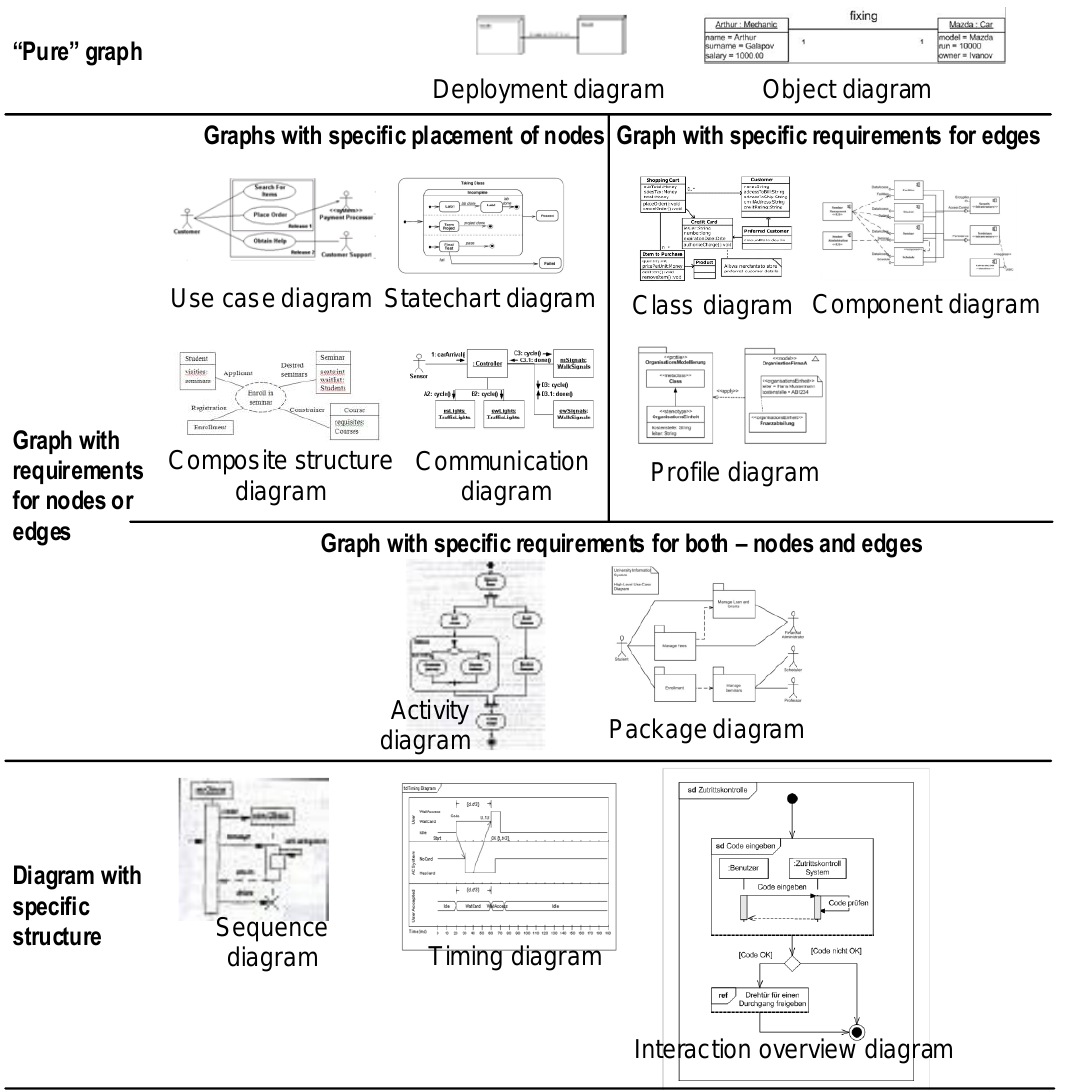
Fig. 1. Classification of UML diagrams in the context of their layout (modified from